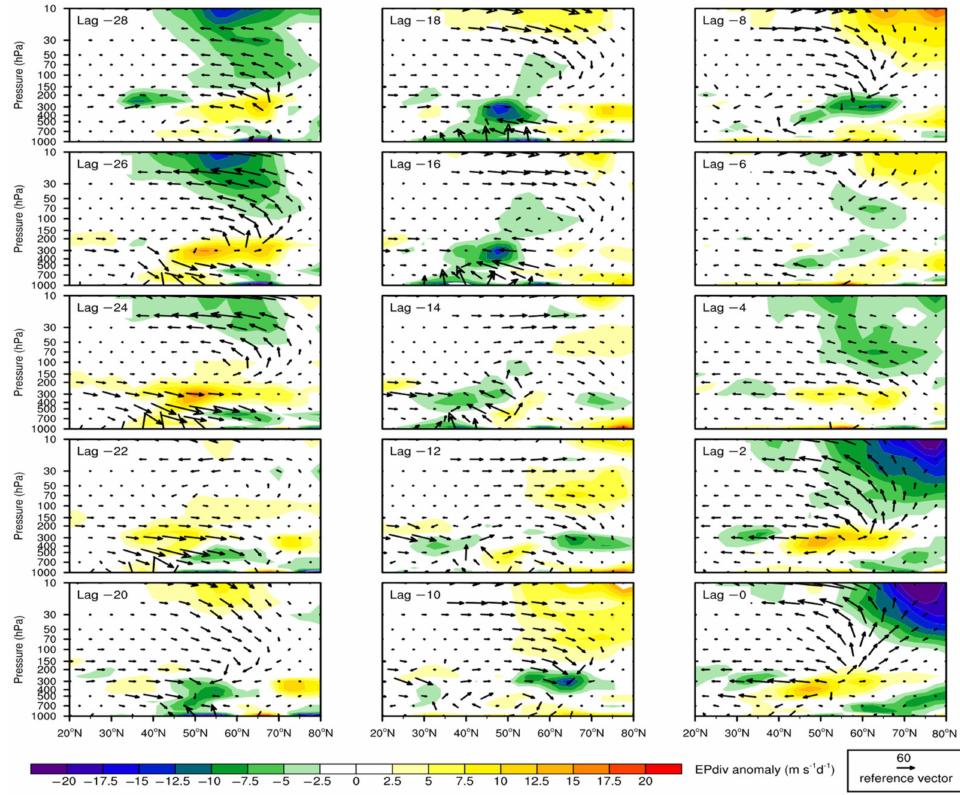
Figure 9. The evolution of 10–60-day filtered of EP flux (vectors; horizontal term: 10 7 m 3 s − 2 and vertical term: 10 5 Pa m 2 s − 2 ) and EP flux divergence (shadings; unit: m s − 1 d − 1 ) for the Whole Northern Hemisphere from the first day of the strong ISO event (14 January, corresponding